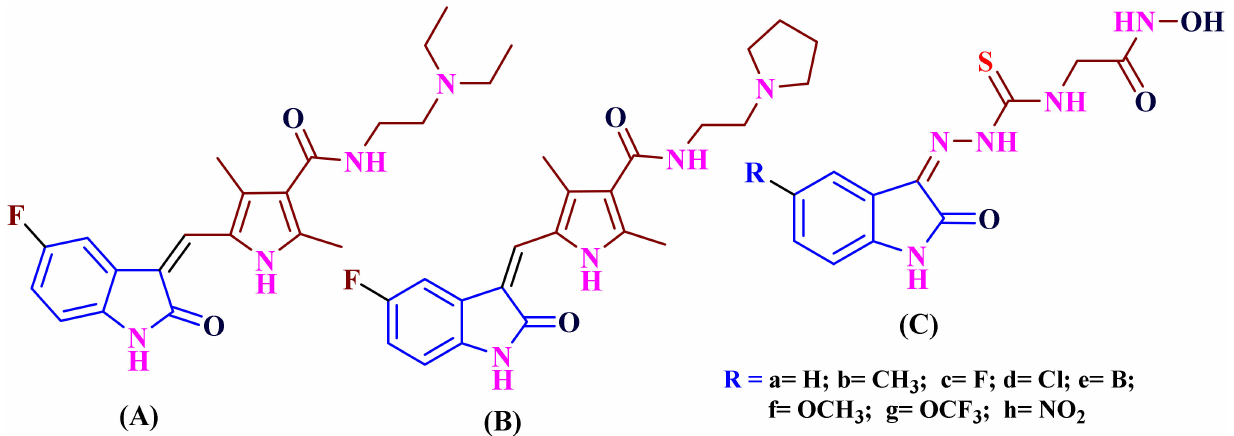
Figure 1. Anticancer drugs: Sunitinib ( A ), Toceranib phosphate ( B ), substituted isatin-hydroxamic acid ( C ) derived from isatin derivatives.